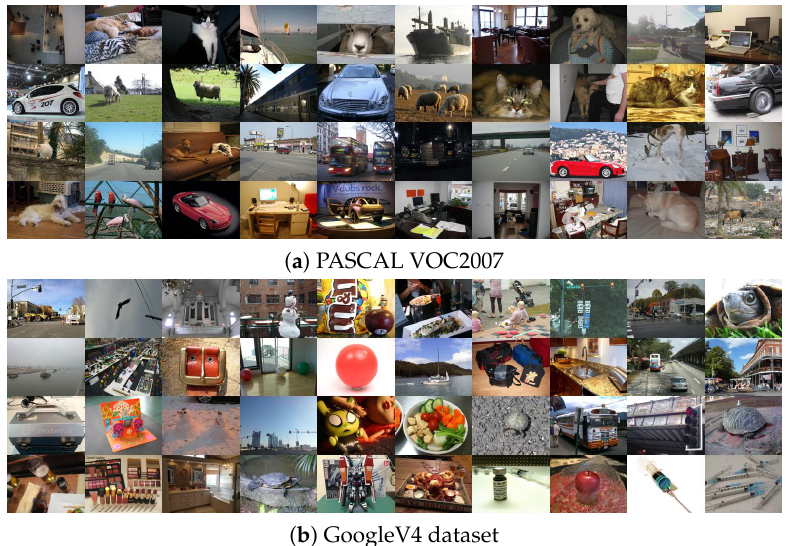
Figure 8. Example images from GoogleV4 and PASCAL VOC2007 datasets